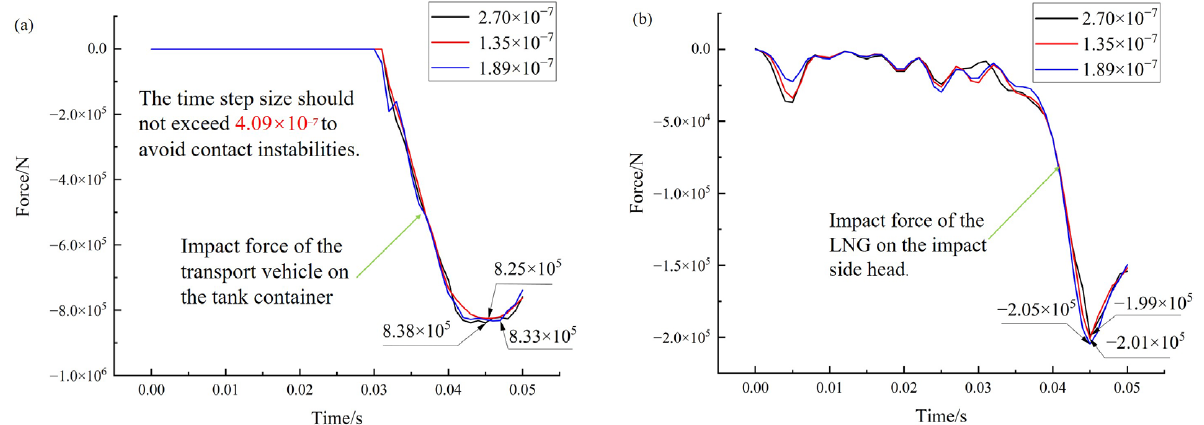
Figure 9. Load step independence verification: ( a ) impact force of the transport vehicle on the tank container, ( b ) impact force of the LNG on the impact side head.